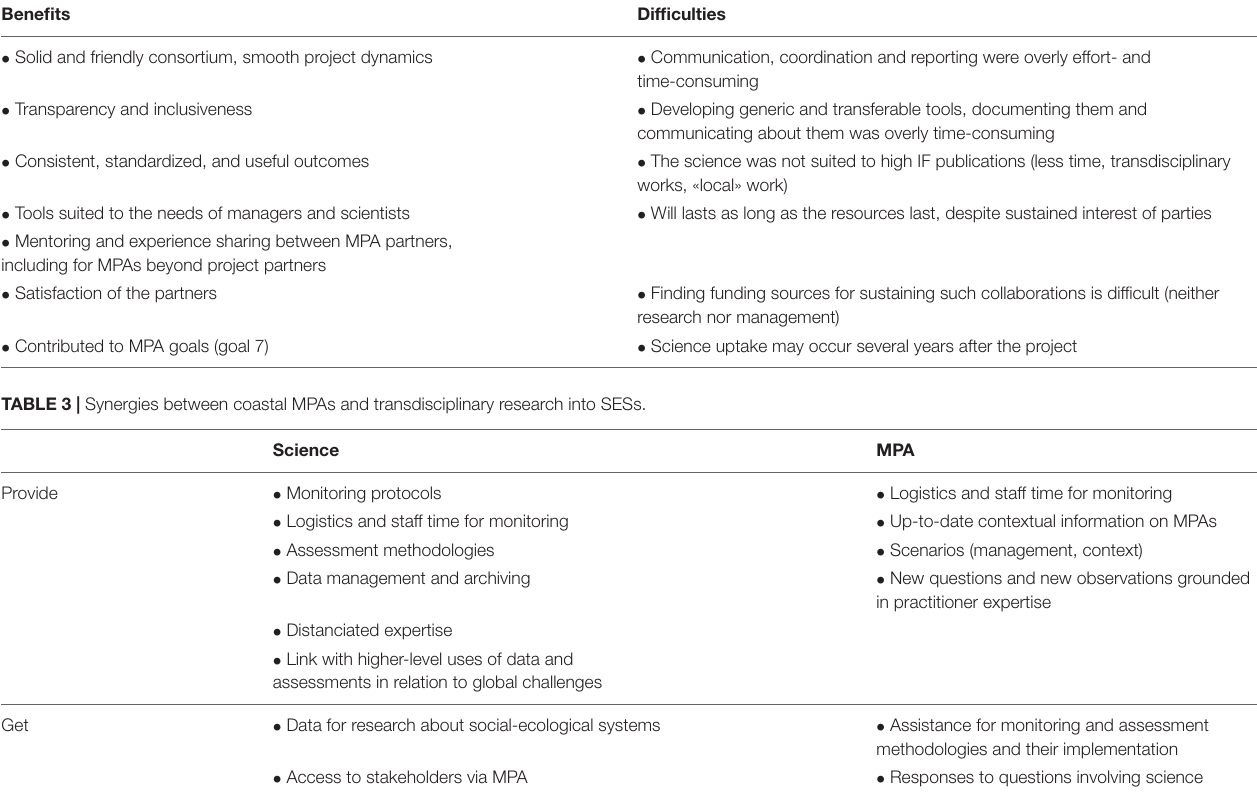
TABLE 2 | Experienced benefits and difficulties in running these transdisciplinary MPA management-oriented projects. Benefits